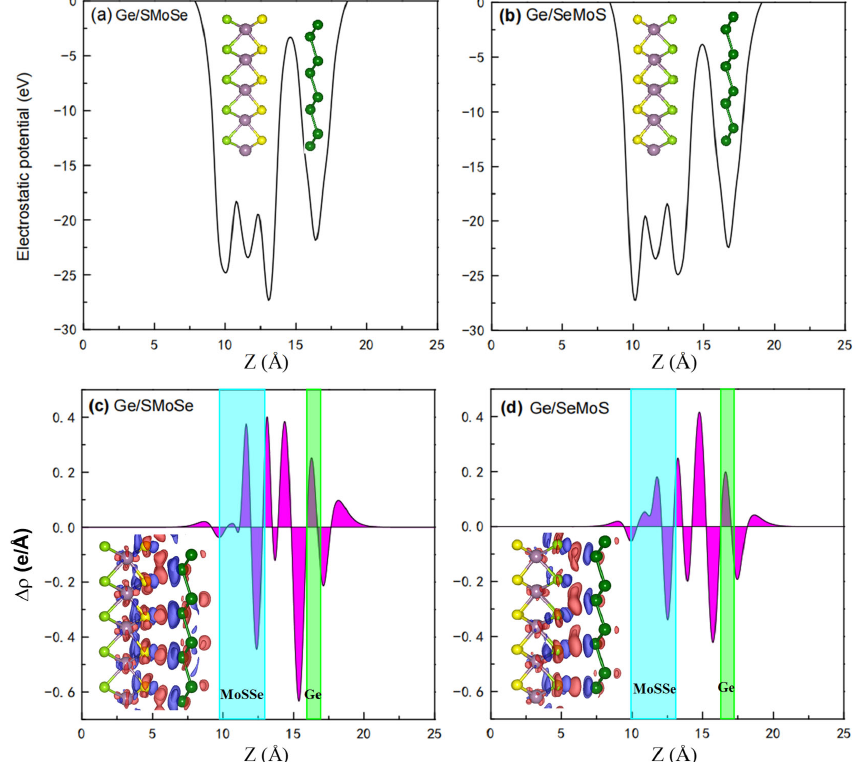
Figure 3. Electrostatic potential of ( a ) Ge/SMoSe and ( b ) Ge/SeMoS. The corresponding planar-averaged differential charge density ∆ ρ are shown in ( c , d ) with locations of component layers marked out. The insets in ( c , d ) are the 3D isosurfaces of charge density difference, where red and blue areas represent electron accumulation and depletion,